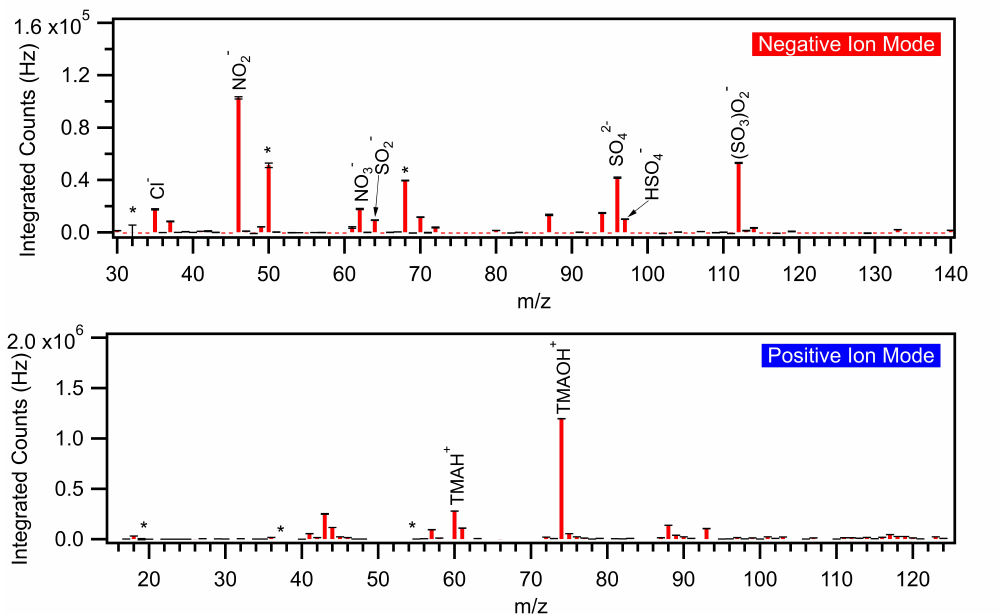
Figure 8. Background-subtracted negative and positive ion mode mass spectra of analyzed TMAO–SA particles. Asterisks (*) denote reagent ions in each spectra, which in negative ion mode are (H 2 O) n O 2 − , and in positive ion mode are (H 2 O) n H 3 O + , where n = 0–2. Negative ion mode was normalized to O 2 − ( m/z 32) signal, and positive ion mode was normalized to H 3 O + ( m/z 19)